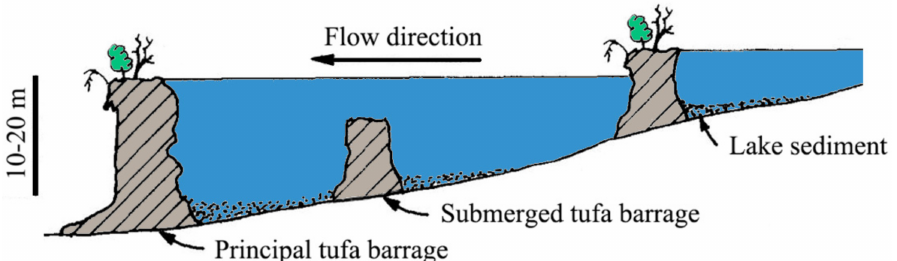
Figure 1. Illustration of the fluviatile barrage model and submerged tufa barrage (Adapted from Ref. [3]. 1990,